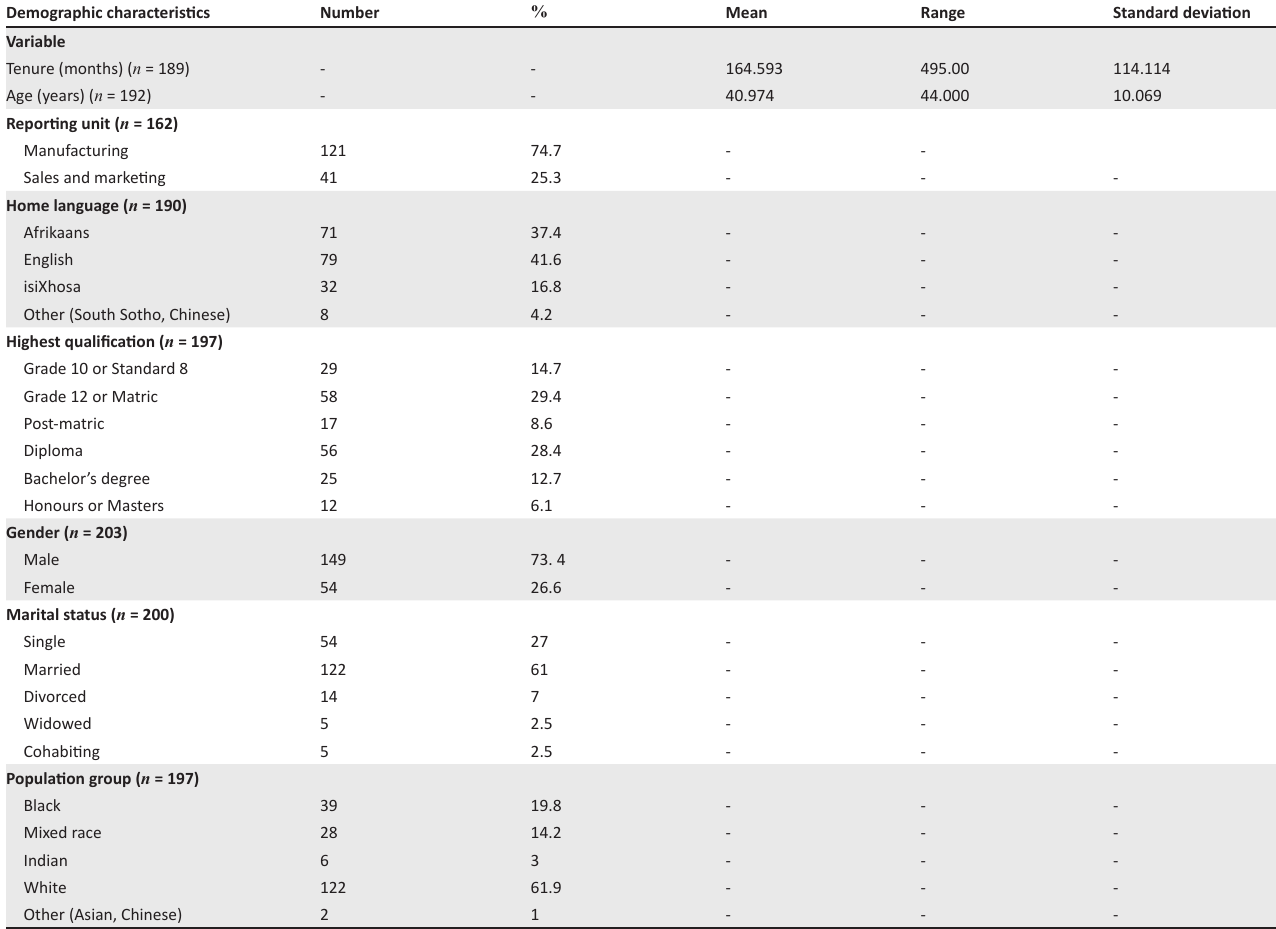
TABLE 2: Demographic characteristics. Demographic characteristics